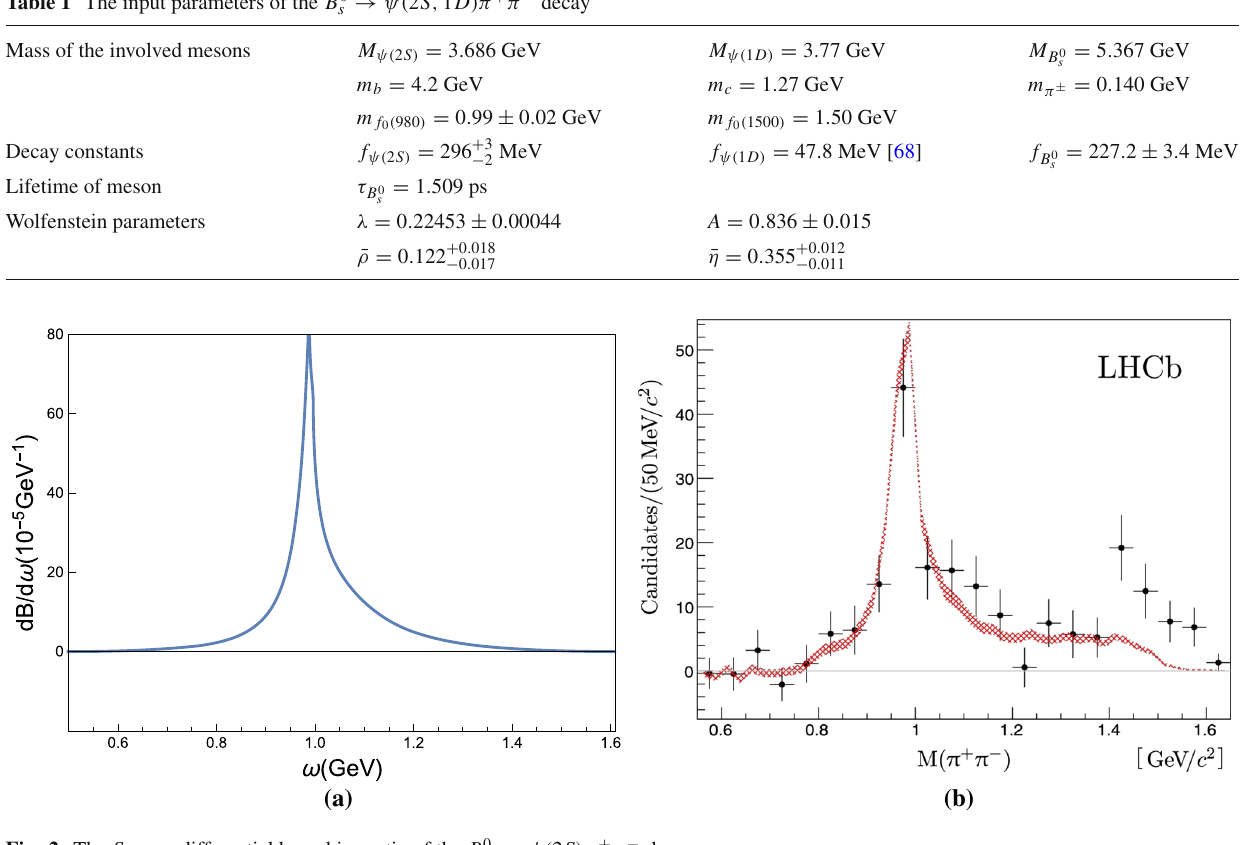
Table 1 The input parameters of the B 0 s → ψ( 2 S , 1 D )π + π − decay